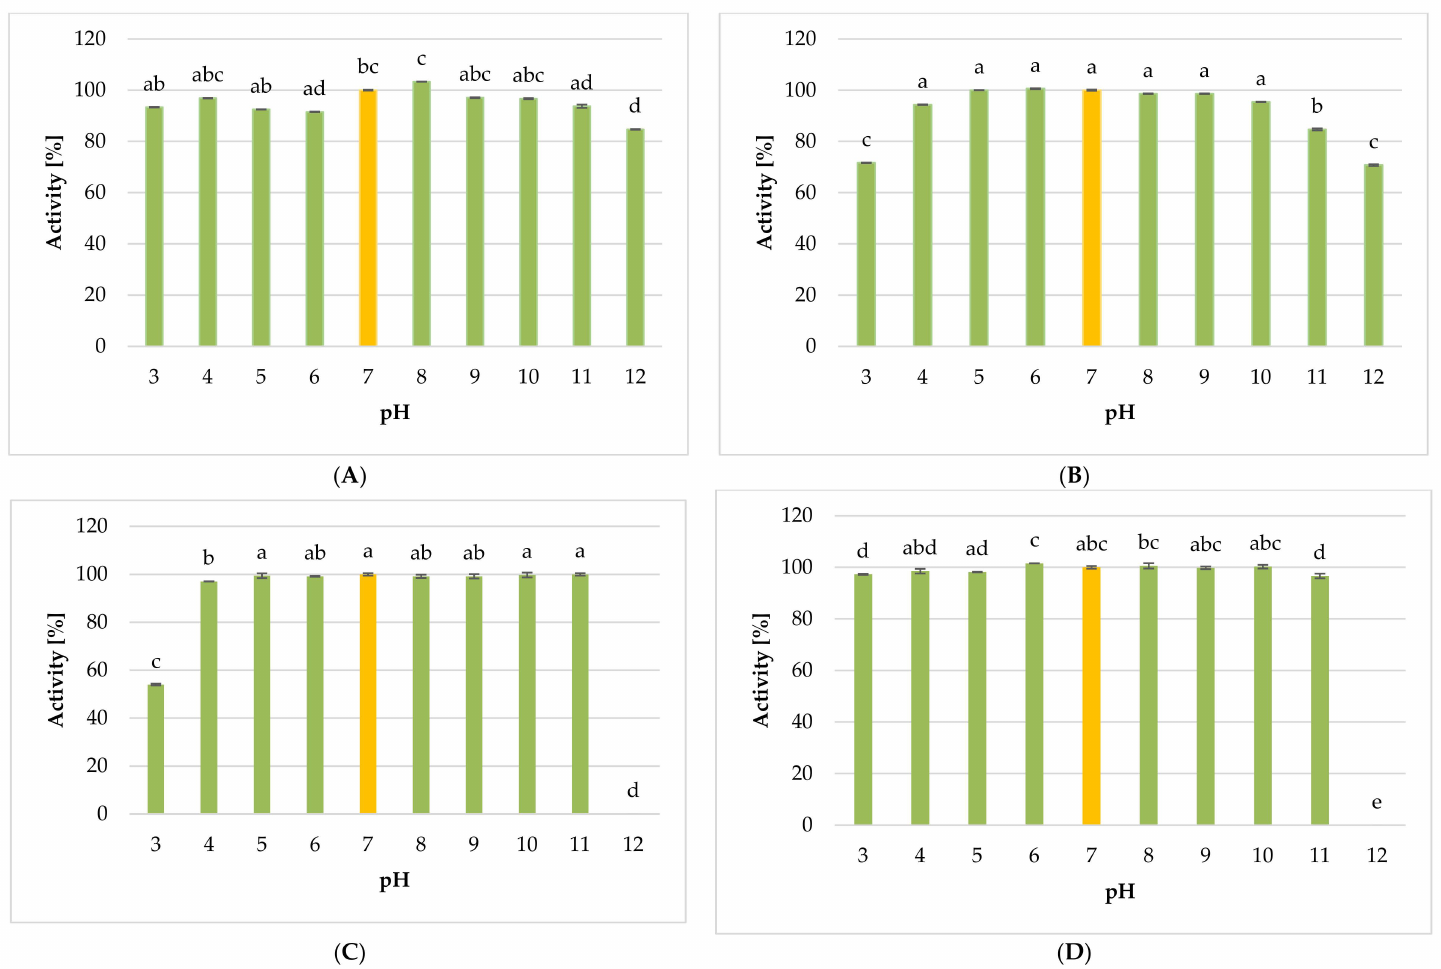
Figure 15. The activity of phages against tested bacterial strains in selected pH values: ( A ) Citrobacter phage KKP 3664, ( B ) Enterobacter phage KKP 3262, ( C ) Enterobacter phage KKP 3263, ( D ) Serratia phage KKP 3264. Letters a, b, c, d, e in superscript indicate homogenous groups at a significance level of p < 0.05, n =